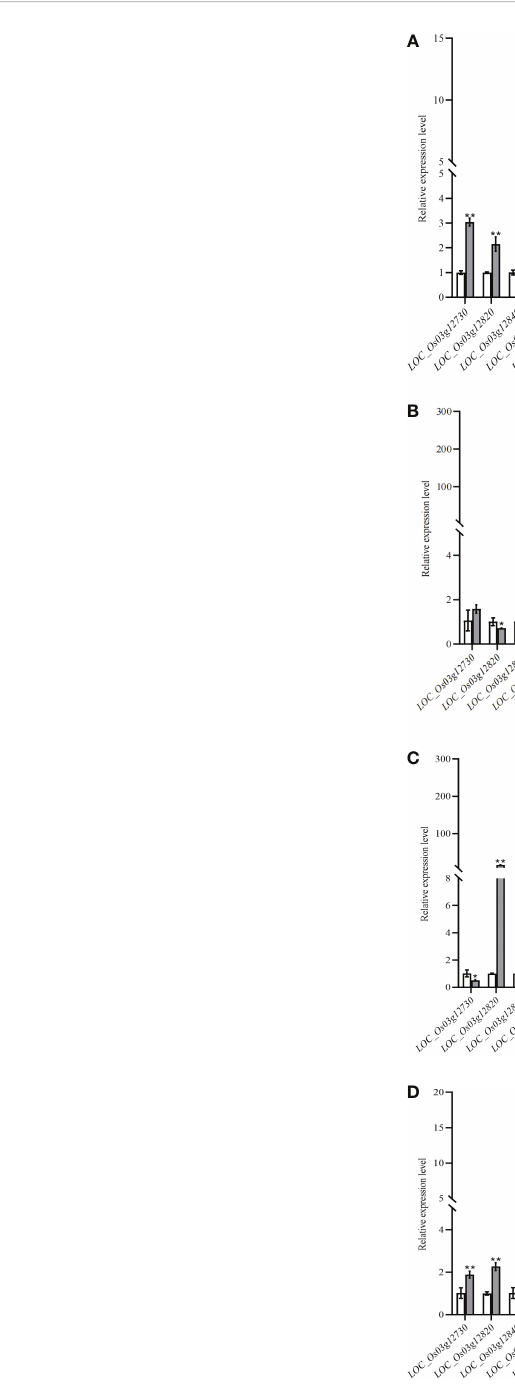
FIGURE 4 Expression of candidate genes for salt tolerance in rice under different concentrations of NaCl. (A) Expression of candidate genes at 0 mM NaCl concentration. (B) Expression of candidate genes at 60 mM NaCl concentration. (C) Expression of candidate genes at 80 mM NaCl concentration. (D) Expression of candidate genes at 100 mM NaCl concentration. * indicates signi fi cance at P ≤ 0.05 by Student ’ s t test, ** indicates signi fi cance at P ≤ 0.01 by Student ’ s t